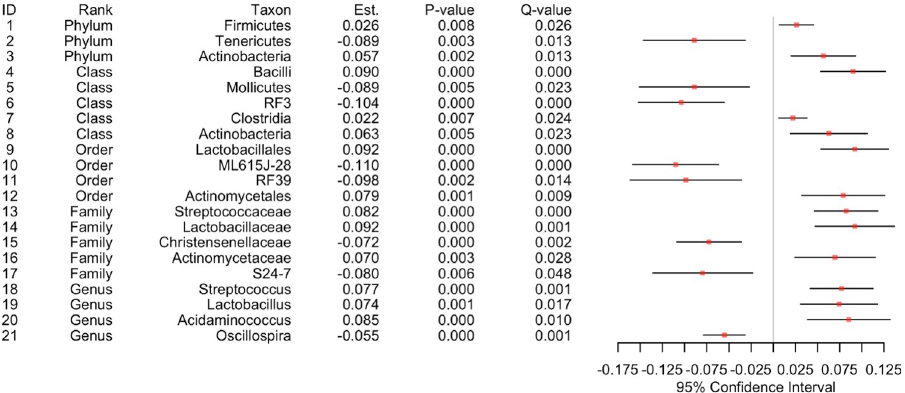
Fig 4. The results for taxonomical analysis in forest plot. Est represents the estimated coefficient, and Q-value represents the FDR-adjusted P-value.